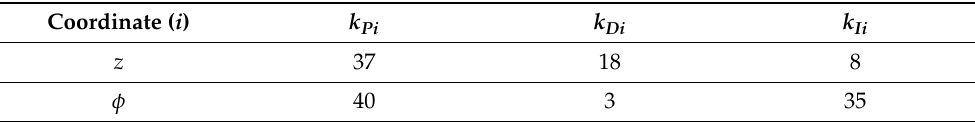
Table 2. PID controller